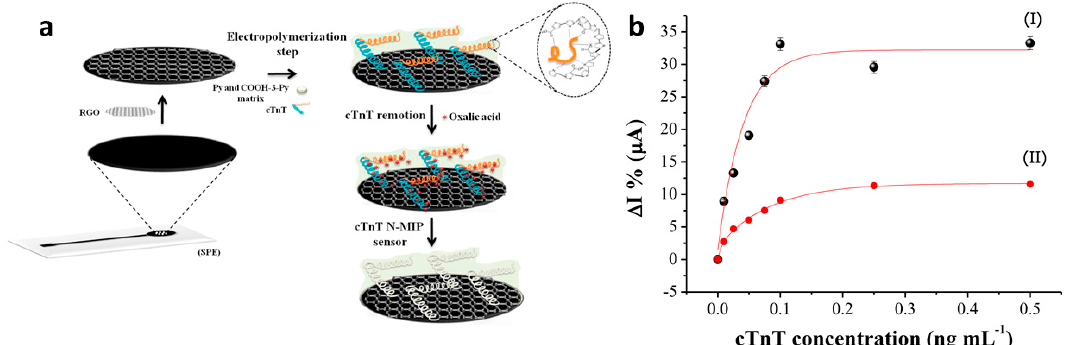
Figure 25. ( a ) Preparation of conductive MIP-based biosensor for the detection of cTnT via the electropolymerization of pyrrole and carboxylated pyrrole in the presence of cTnT, followed by cTnT removal using oxalic acid. ( b ) Response of an MIP sensor (black dots, I) versus a non-imprinted sensor